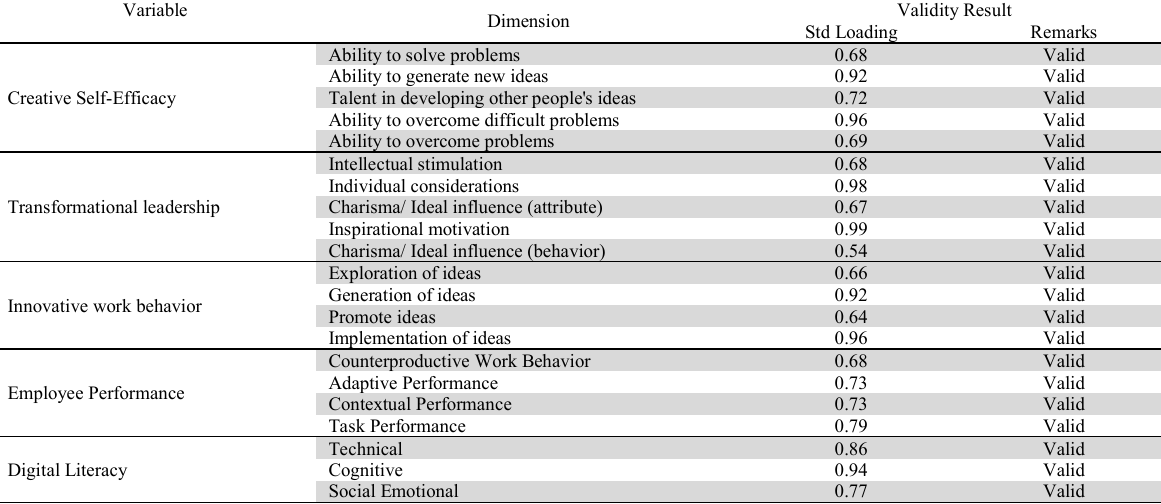
Factor Analysis